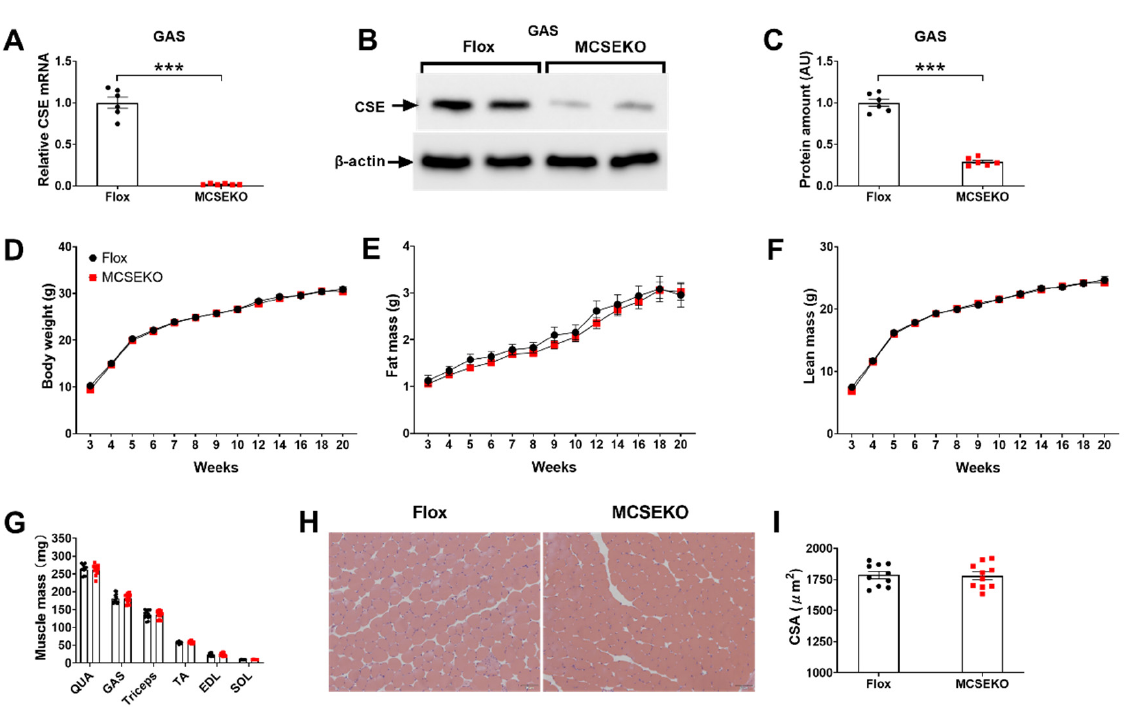
Figure 1. The expression level of CSE and characterization of body weight, body composition, muscle mass, and musculature morphology in MCSEKO mice. MCSEKO mice and littermate Flox mice were housed in standard conditions until 21-weeks-old, and then sacrificed under deep anesthesia. The body weight, body composition, and muscle mass were measured every 1 to 2 weeks as indicated. Q-PCR and Western blotting analysis were used to determine CSE expression in the skeletal muscle. ( A ) CSE mRNA levels in the GAS of Flox mice and MCSEKO mice ( n = 6 in each group). ( B , C ) CSE protein expression in the GAS was detected by western blot analysis in the mice ( n = 6 in each group). ( D – F ) The body weight and body composition were measured in Flox mice and the MCSEKO mice. The body weight ( D ), fat mass ( E ), and lean mass ( F ) of Flox mice and MCSEKO mice ( n = 12 in each group). ( G ) The muscle weight of the mice ( n = 12 in each group). ( H ) H&E staining of GAS (scale bars, 50 µ m). ( I ) the GAS cross section area in the mice ( n = 12 in each group). All data were expressed as means ± SEM. *** p <